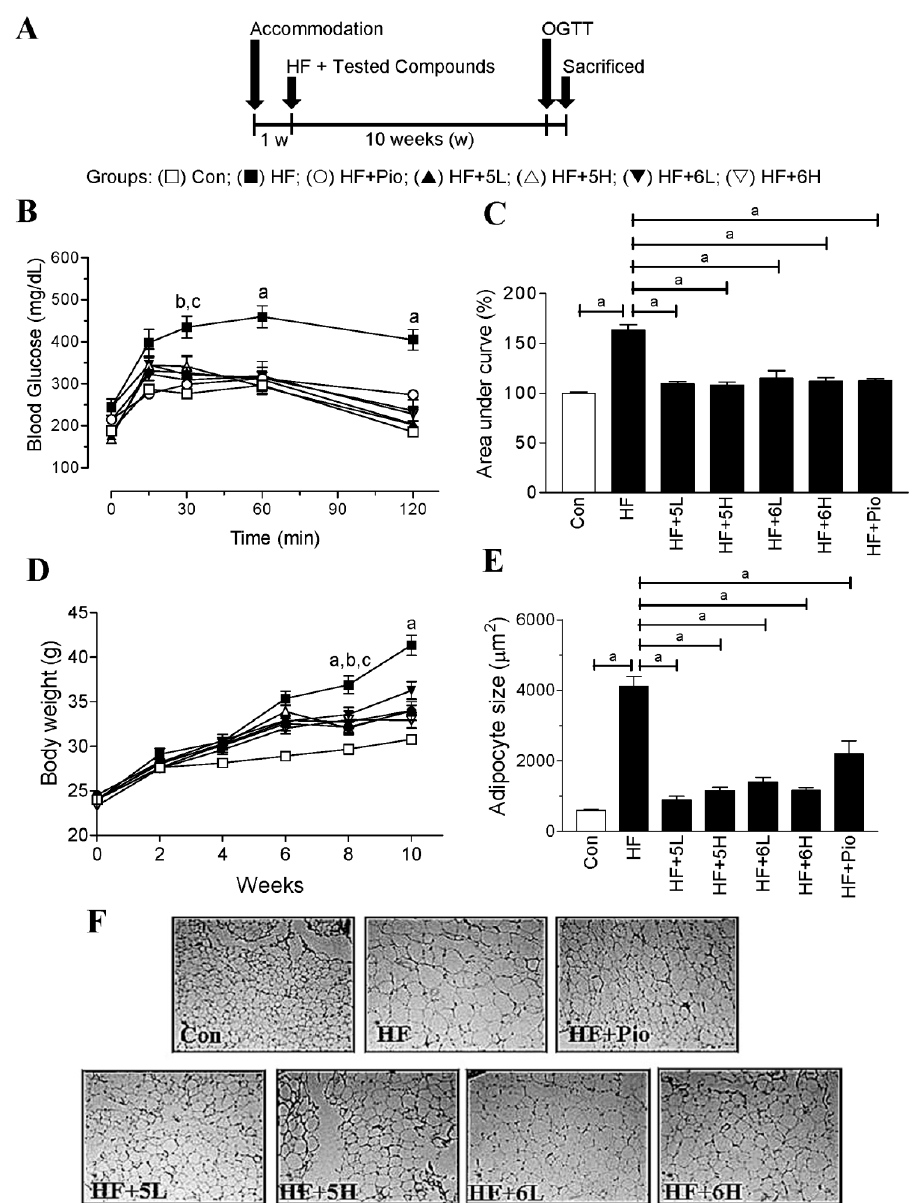
Figure 6. Anti-obesity and antidiabetic effects of compounds 5 and 6 in the HF-fed mice. ( A ) Illustration of the animal protocol; ( B ) results of OGTT in the mice; ( C ) area under curve (AUC) of the OGTT results; ( D ) body weight changes in the mice; ( E ) the quantitative results of the adipocyte size in panel F; ( F ) morphology of the visceral adipose tissues were evaluated by hematoxylin and eosin staining. The original magnification of the tissue images in panel F is 200 × under the light microscope. Con: normal-diet-fed; HF: high-fat-diet-fed; HF + 5L: high-fat-diet fed with compound 5 (6.75 mg/kg/day); HF + 5H: high-fat-diet fed with compound 5 (33.75 mg/kg/day); HF + 6L: high-fat-diet fed with compound 6 (6.75 mg/kg/day); HF + 6H: high-fat-diet fed with compound 6 (33.75 mg/kg/day); HF + Pio: high-fat-diet fed with pioglitazone (6.75 mg/kg/day). Data are mean ± SD. In panel B, a : p < 0.001, HF group compared with all the other groups; b : p < 0.01, HF group compared with Con, HF + 5L, HF + 6H, and HF + Pio; c : p < 0.05, HF group compared with HF + 5H, and HF + 6L. a : p < 0.001, compared with HF group in panel C and E. In panel D, a : p < 0.001, HF group compared with all the other groups; b : p < 0.01, HF group compared with HF + 5L, HF + 6H, and HF + Pio; c : p < 0.05, HF group compared with HF + 6L. For detailed statistical results of ( B , D ) see Table S2.